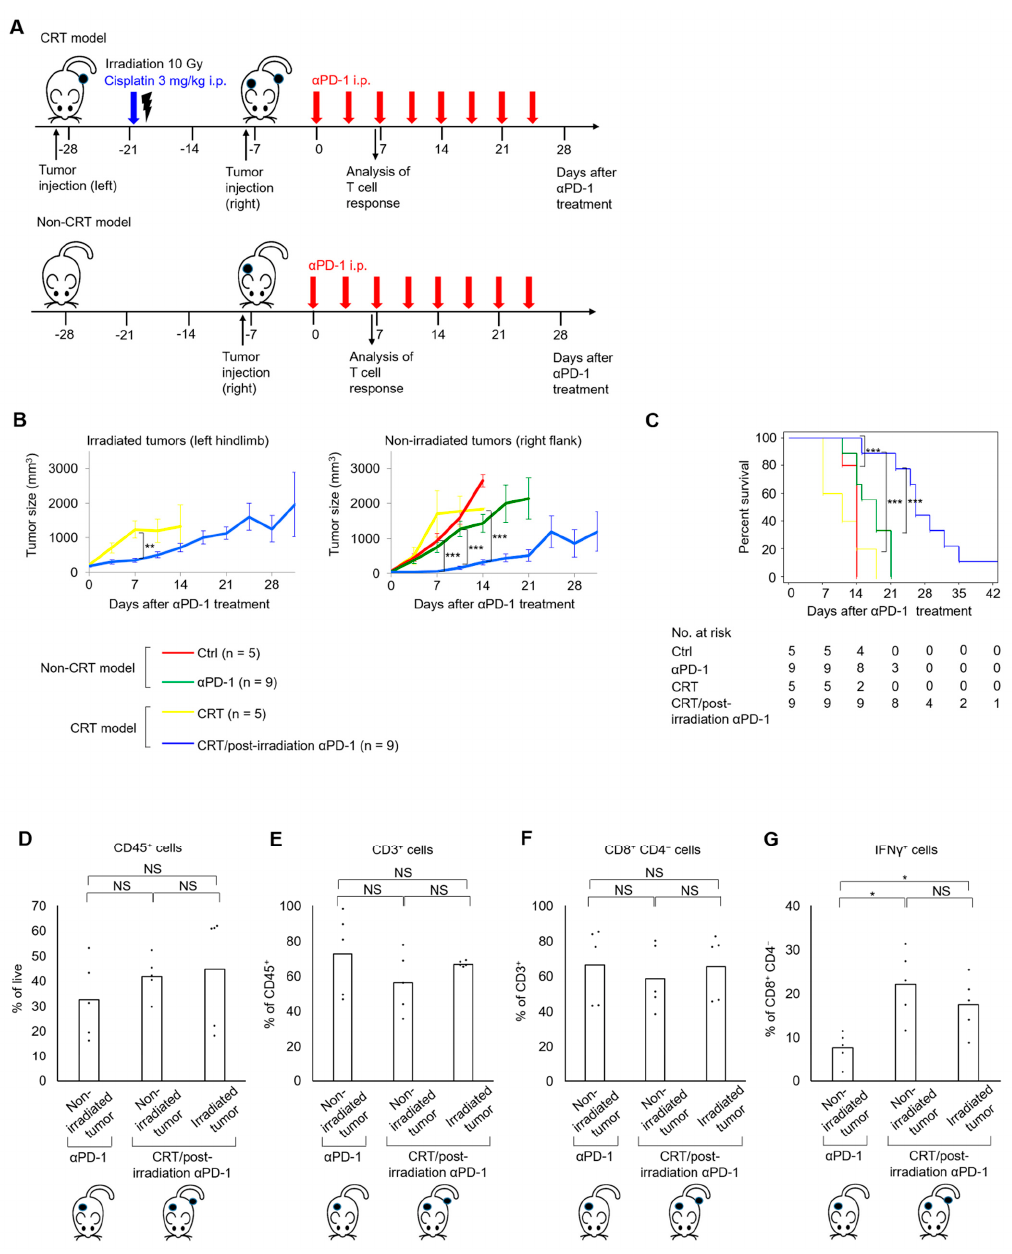
Figure 3. The combination of cisplatin and irradiation potentiated the efficacy of postirradiation anti–PD-1 treatment in MB49 tumor-bearing mice. ( A ) Scheme for tumor inoculation, treatments, and T cell analysis. For the CRT model (top), six- to seven-week-old mice are injected with MB49 cells in the left hindlimb, and seven days later, receive cisplatin at 3 mg/kg and irradiation with a single fraction of 10 Gy to the left hindlimb. The mice are injected with MB49 cells in the right flank 14 days after irradiation, and seven days later, receive anti–PD-1 treatment (or its isotype controls). For the Non-CRT model (bottom), only a right flank tumor is established in the mice, and cisplatin and irradiation are not given. ( B ) MB49 tumor growth curves of irradiated tumors in the left hindlimb (left) and nonirradiated tumors in the right flank (right). ( C ) Survival curves of mice. The log-rank test is used to compare survival curves. ( D – G ) Proportions of CD45 + cells in the live cells ( D ), CD3 + cells in the CD45 + subpopulation ( E ), CD8 + CD4 − cells in the CD3 + subpopulation ( F ), and IFN γ + cells in the CD8 + CD4 − subpopulation ( G ) in single-cell suspensions of the irradiated and nonirradiated tumors on day seven in mice treated with CRT/postirradiation anti–PD-1 treatment compared to those of the nonirradiated tumors on day seven in mice treated with anti–PD-1 treatment alone ( n = 5/group). All data are shown as the mean ± standard error of the mean (SEM). Asterisks indicate p -values comparing two groups, as indicated in the figure. NS, not significant; * p < 0.05; ** p < 0.01; *** p <